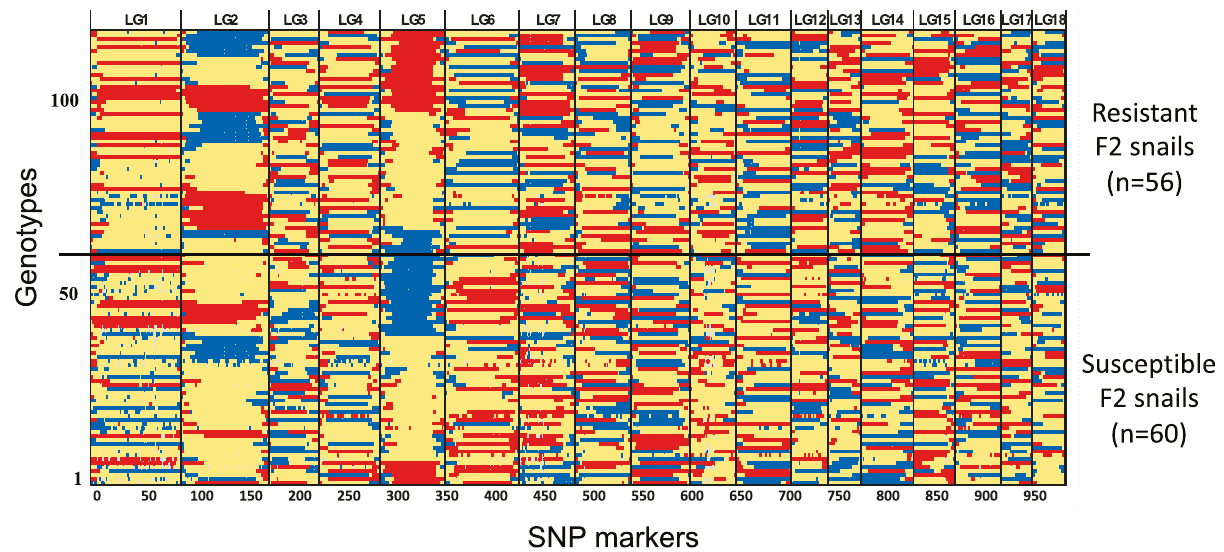
Fig. 4 Graphical representation of genotypes on 18 linkage groups. Blue, red, and yellow colors represent alleles that are derived from resistant iBS90, susceptible iM line and heterozygous (from both parents), respectively. The white color indicates missing information. Black vertical lines indicate the boundaries between LGs. The y-axis was sorted by genotypes of QTL regions on LG5 and LG2 to show the proportion of genotypes in resistant group (upper) and susceptible group (lower).